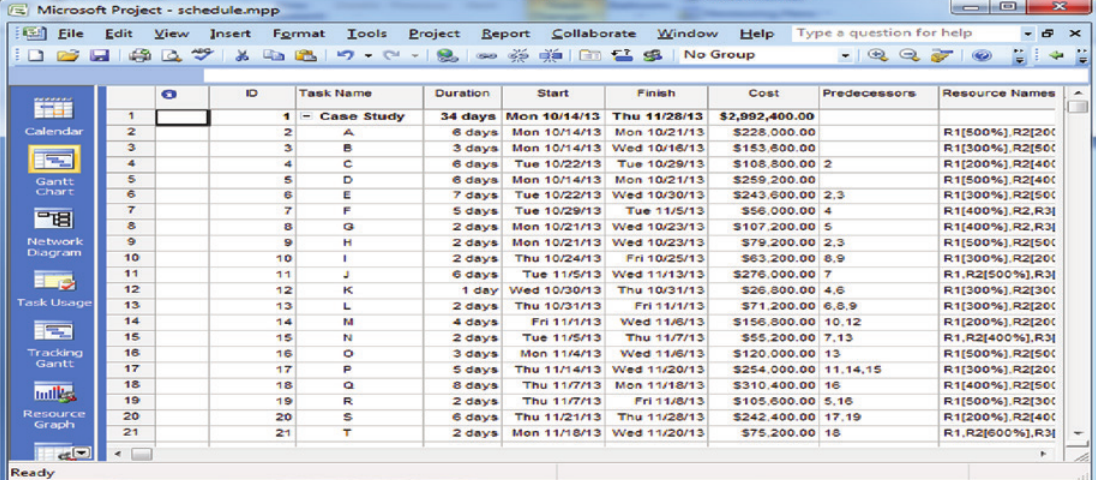
Figure 1: Project Plan in MS